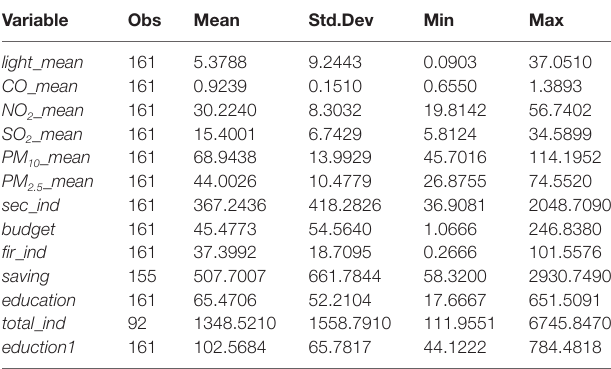
TABLE 2 | Descriptive statistics of variables.